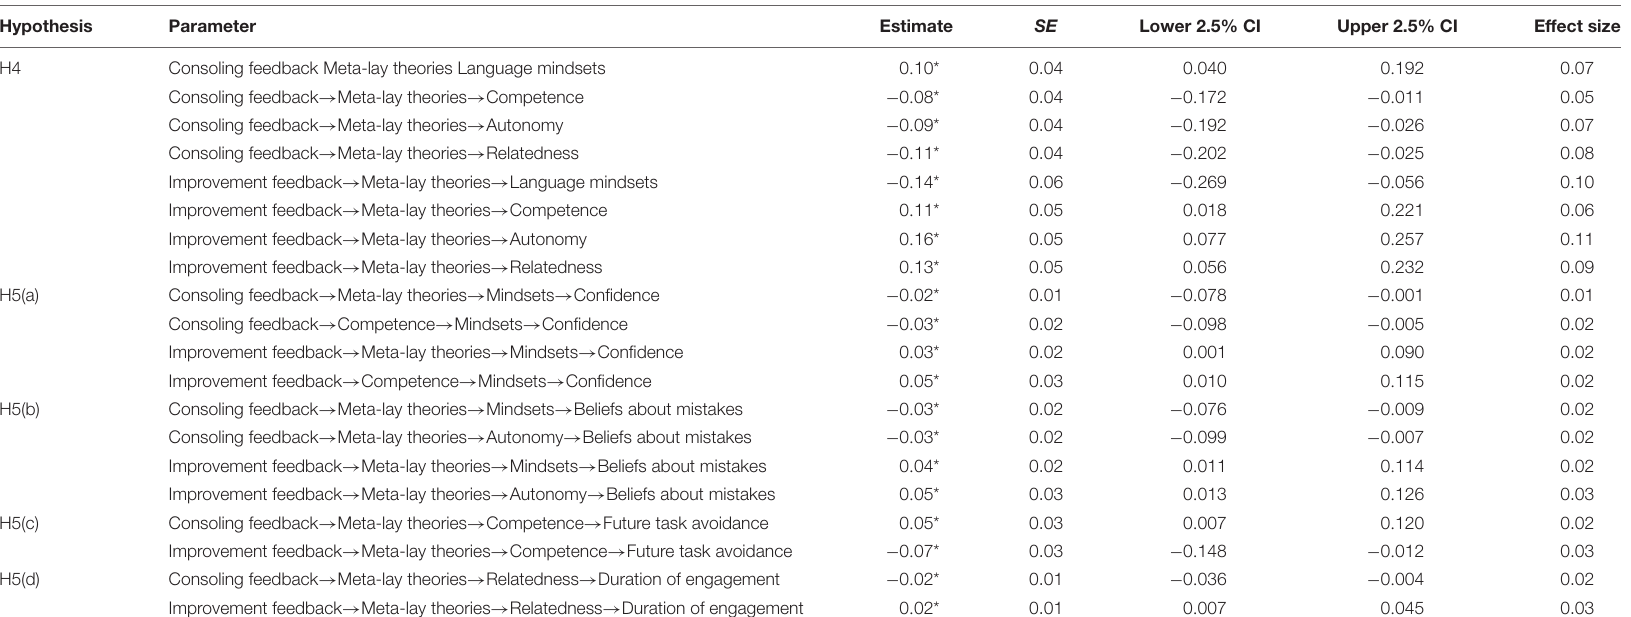
TABLE 4 | Indirect effects for the path model: estimates, standard error (SE), and 95% bias-corrected confidence intervals (CIs). Hypothesis Parameter Estimate SE Lower 2.5% CI Upper 2.5% CI Effect size H4